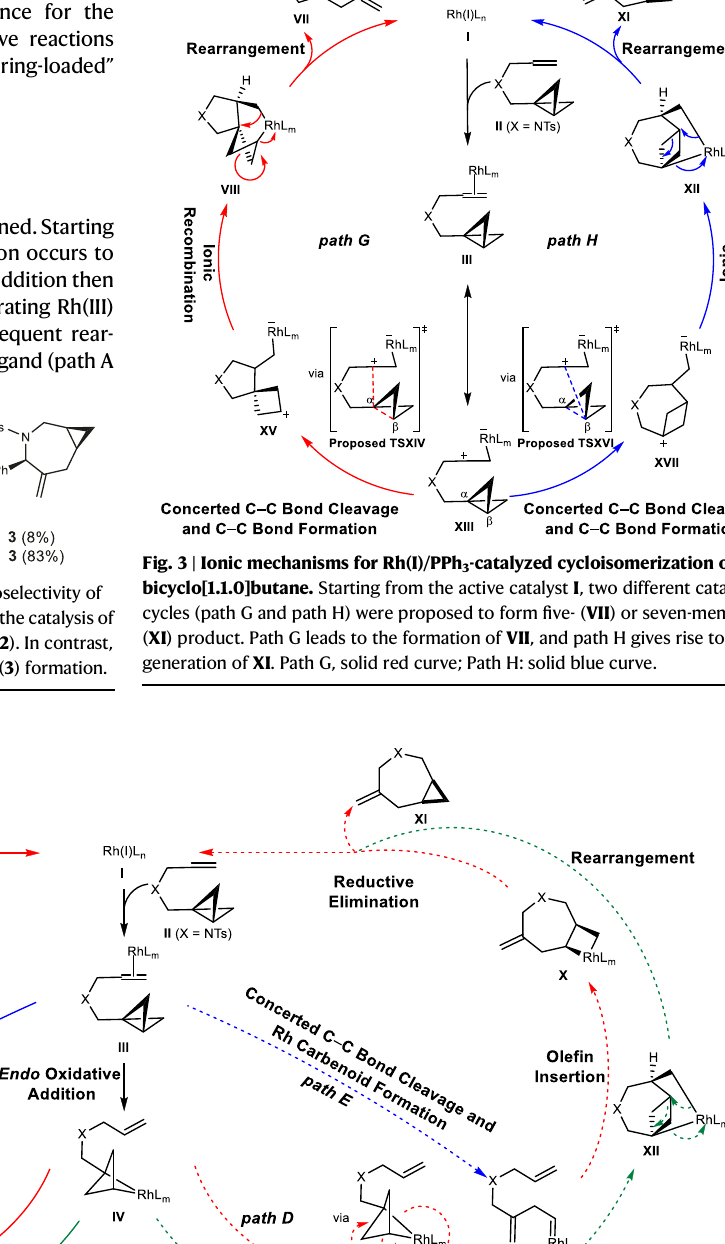
tothegenerationof XI .PathA,solidredcurve;PathB,solidbluecurve;PathC,solid green curve; Path D, dotted red curve; Path E, dotted blue curve; Path F, dotted green curve.